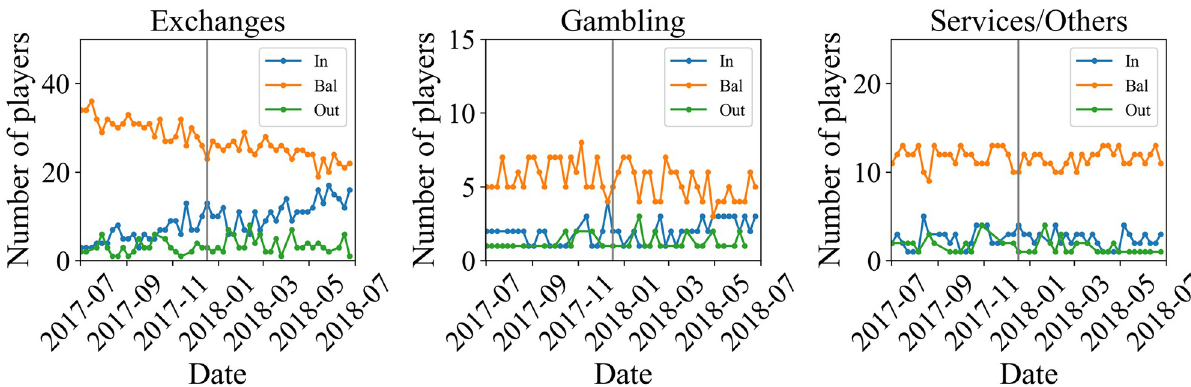
Fig 7. Number of identified regular In-, Bal-, and Out-players for Bitcoin categorized as exchange (left), gambling (middle), and service/others (right). In-, Bal-, and Out-players are plotted in blue, orange, and green, respectively. The gray vertical line represents the week that contains the day of the peak.